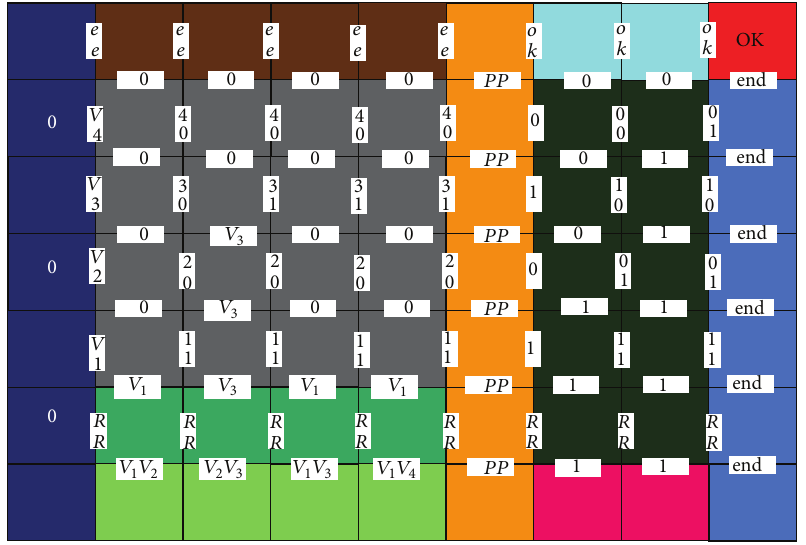
Figure 6: The final configuration 𝐹 𝑘 produced by the tile system SYS 𝑘 for the example of Figure 4.